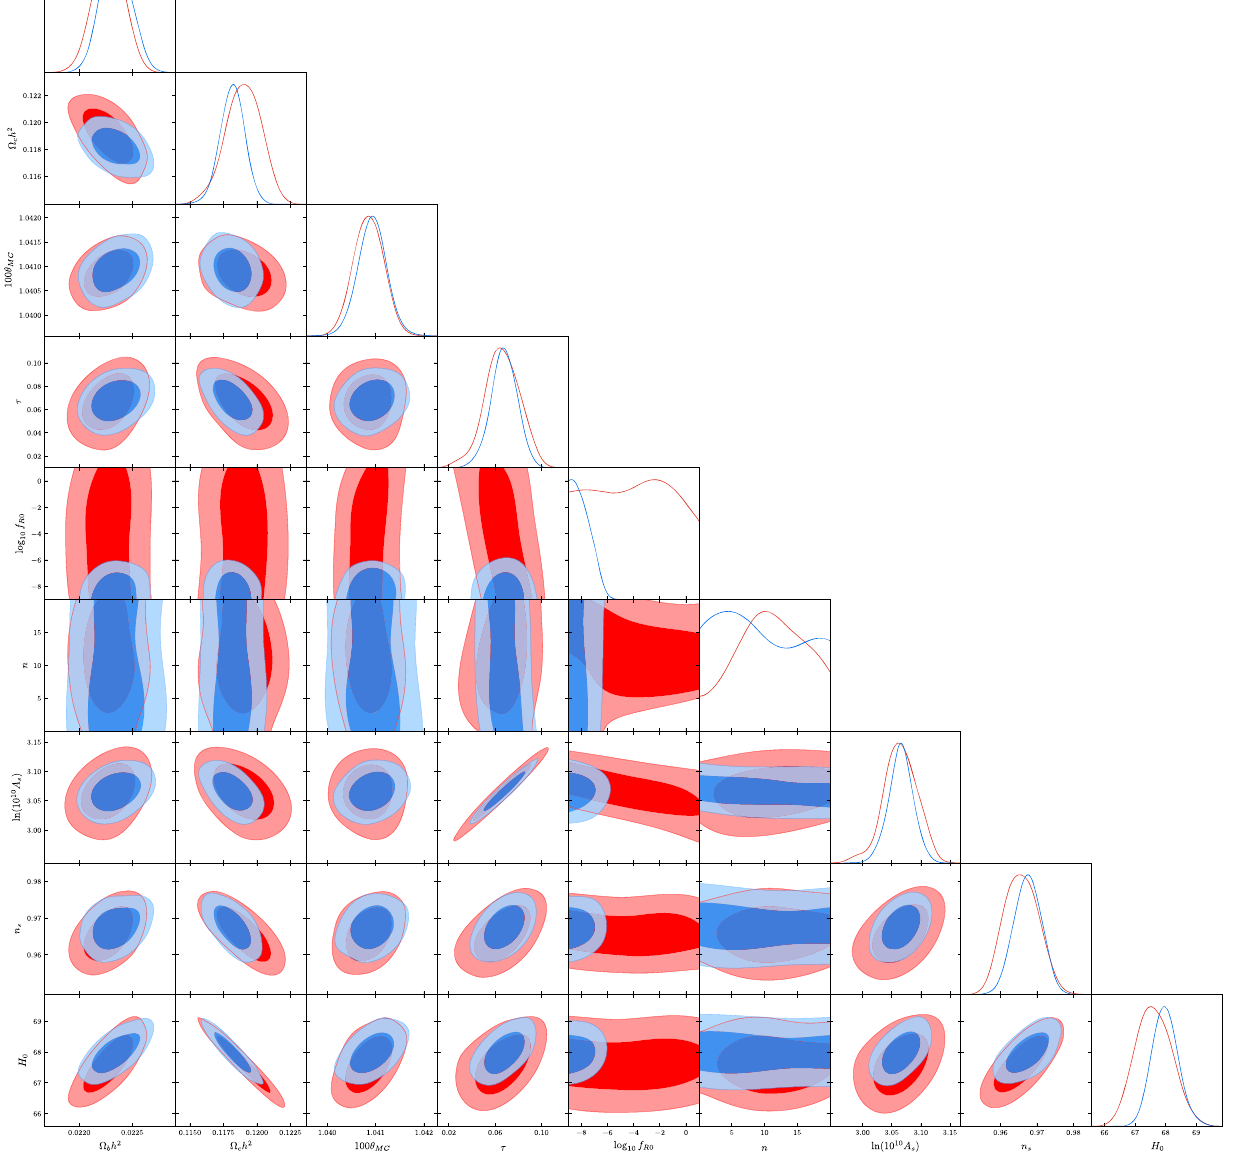
Fig. 7 The marginalized constraints on the HS f ( R ) model with free n are shown by using the “C” (red) and “CBSHR” (blue) datasets,